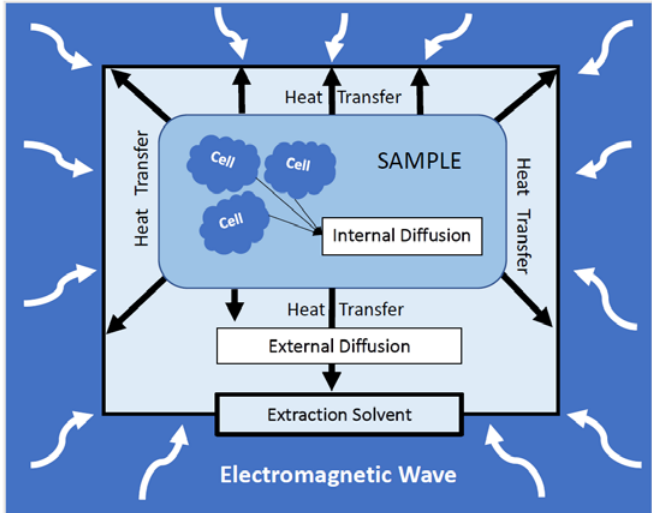
Figure 5. Schematic mechanism of the microwave-assisted extraction system.